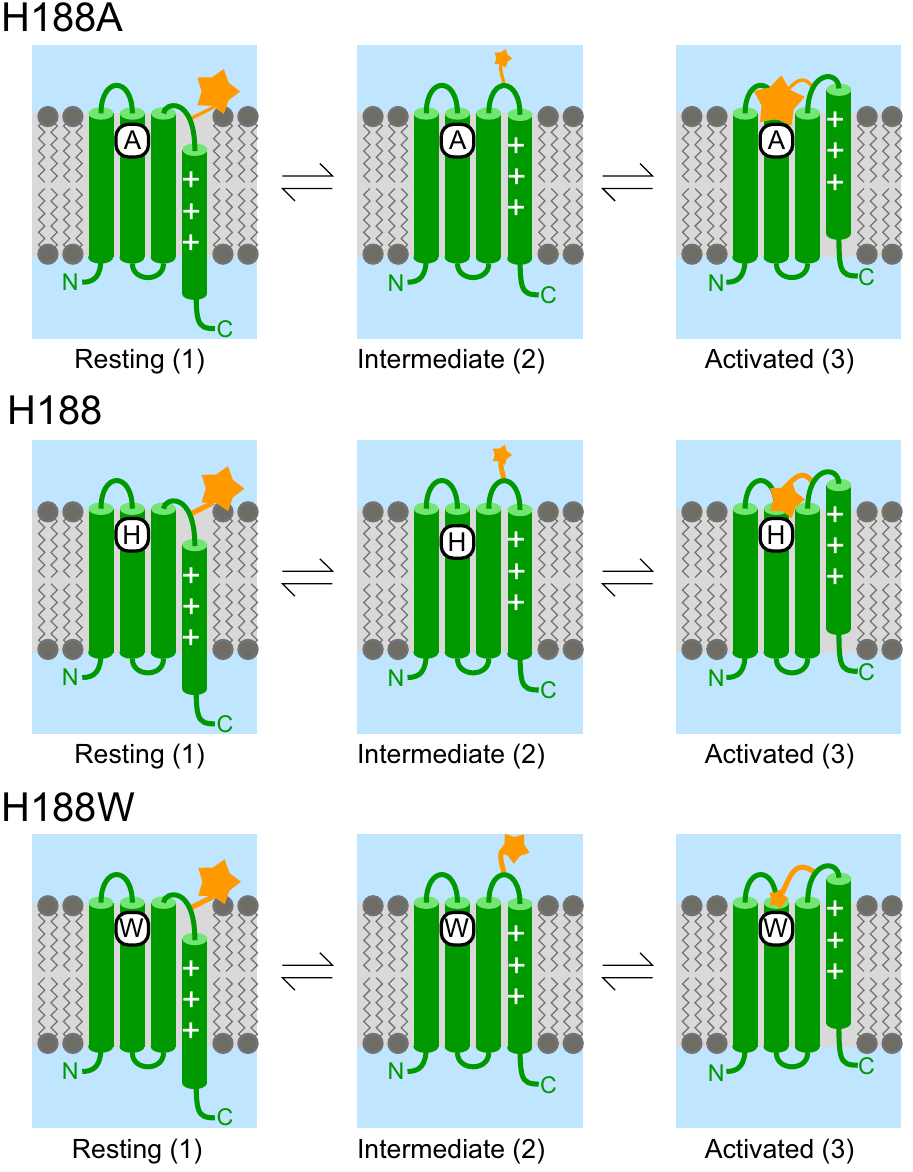
Fig. 7 Model of VCF signal generation during CiHv1 conformational changes. The model assumes two major VSD movements among three states traced by the attached TAMRA (orange star). The resting (1), the intermediate (2) and the activated (3) states are associated with different fl uorescence intensities (F1, F2, F3) in each construct for a single TAMRA molecule. In the H188A/H179A mutant (top row panels) there is no quenching residue near TAMRA. In response to a depolarizing pulse, the dye fi rst moves away from the lipid bilayer from state 1 to 2 and the fl uorescence intensity decreases, since F1 > F2. Subsequently, there is a second motion from state 2 to 3, when the dye approaches the lipid bilayer, and the fl uorescence increases to a level above the initial one: F3 > F1 > F2. In single alanine mutants and the CiHv1-E241C there is/are weak quenching residue(s) near the dye (middle row panels). The motion is similar to that in the top row panels, but during the second motion as TAMRA approaches both the quencher and the bilayer, the latter effect overrides the weak effect of the quencher, thus, the fl uorescence increases but remains below the original one: F1 > F3 > F2. In the tryptophan mutants (bottom row panels) there is/are strong quenching residue(s) near the dye. During depolarization, it moves similarly to the top row panel motion, away from the membrane and toward the quenching residue from state 1 to 2 and the fl uorescence intensity decreases, F1 > F2. Subsequently, in the second motion from state 2 to 3, TAMRA approaches both the membrane and the quencher, the latter effect overrides the lipid effect and fl uorescence further decreases: F1 > F2 >